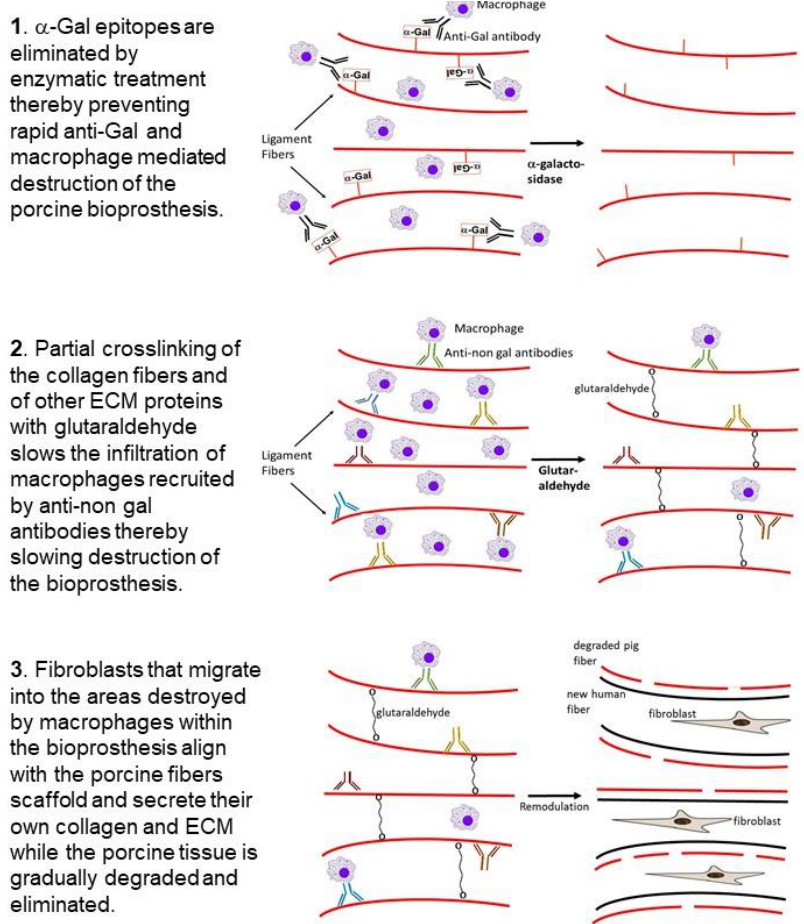
Figure 3. Hypothesis on humanization of porcine BTB or BHV bioprostheses implanted into patients with torn ACL or with impaired heart valve, respectively: Stage 1. Elimination of α -gal epitopes from the bioprosthesis by incubation with recombinant α -galactosidase prevents accelerated destruction by anti-Gal and by the macrophages it recruits. Stage 2. Partial crosslinking with glutaraldehyde creates “speed bumps” that slow macrophage infiltration following recruitment of the macrophages into the bioprosthesis by anti-non-gal antibodies binding to many porcine protein antigens. Colors of the antibody molecules vary because of different specificities of anti-non-gal antibodies. The macrophages bind via Fc-receptors to the Fc “tail” of anti-non-gal IgG molecules that interact with the porcine antigens of the ECM, and of non-viable cells in the implanted bioprosthesis. Stage 3. The porcine tissue is gradually degraded by the infiltrating macrophages. Fibroblasts that follow the macrophages align with the porcine collagen fibers scaffold and secrete their collagen and other ECM components. This concomitant destruction and reconstruction (remodulation) results in humanization of the bioprosthesis by gradual replacement of the porcine tissue with autologous permanently functional ACL or heart